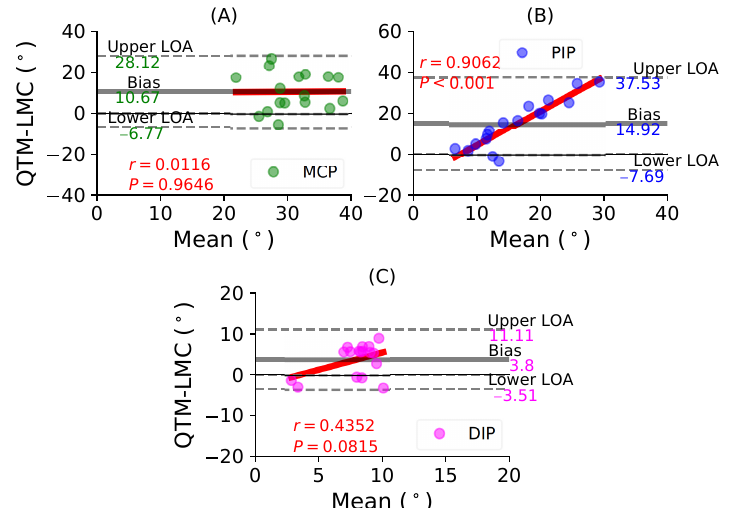
Figure 8. A BA plot of middle finger flexion. ( A ) MCP joint comparison, ( B ) PIP joint and ( C ) DIP joint.